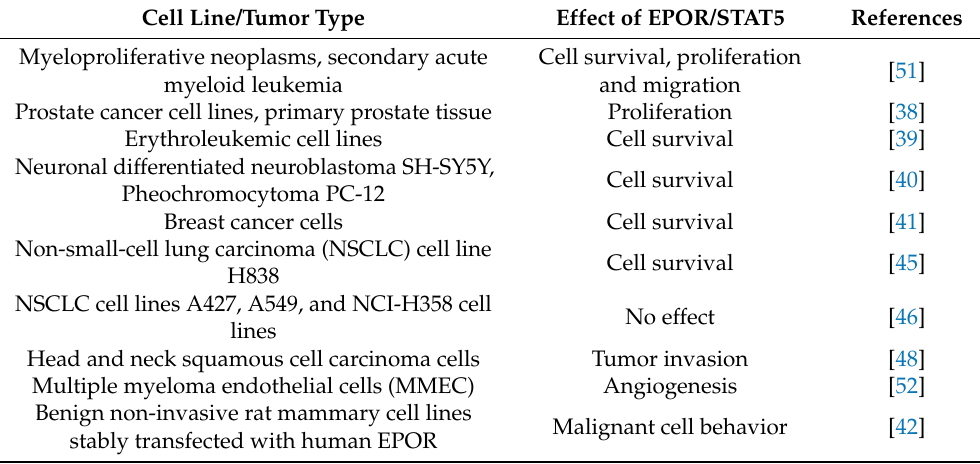
Table 2. The list of cell lines and tumors with impact of EPOR/STAT5 signaling on the cell processes. Cell Line/Tumor Type Effect of